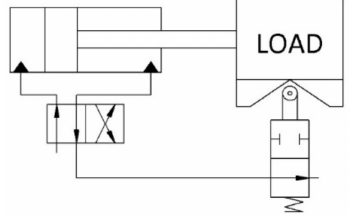
Figure 9. Deceleration valve (DV)